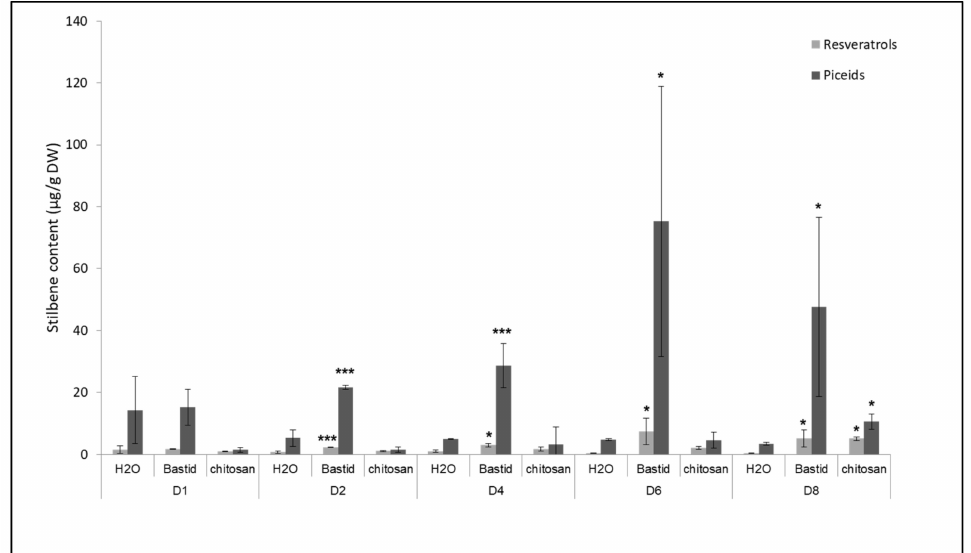
Figure 5. Time course of stilbene production in grapevine leaves treated by Bastid ® or chitosan. Treated leaves were collected on D1, D2, D4, D6, and D8 after Bastid ® , chitosan, and H 2 O (control) treatments. Resveratrol ( trans- and cis -isomers) and piceid ( trans- and cis -isomers) are expressed in µ g/g dry weight (DW). Values represent the means ± SD of duplicate experiments. Asterisks (*) indicate significant differences ( p: *** < 0.001; * < 0.05) between the elicitors and the H 2 O